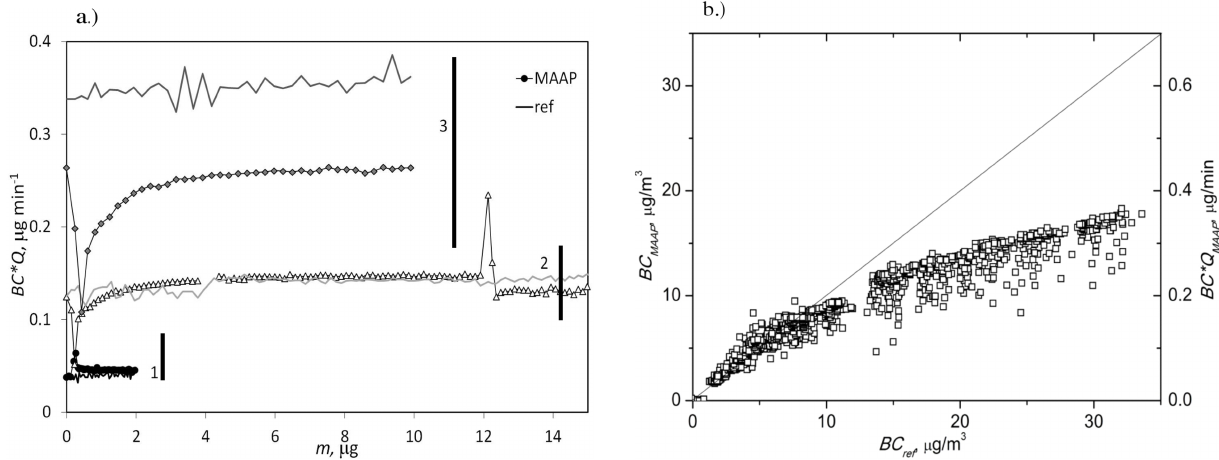
Fig. 3. (a) Examples of the artifact temporal response. Symbol lines indicate data from the high flow rate MAAP, and solid lines data from the reference MAAP. Regimes 1, 2 and 3 correspond to accumulation rates (BC × Q ) of 0.04–0.08µgmin − 1 , 0.08–0.14µgmin − 1 and > 0.14µgmin − 1 , respectively. See text for details. (b) Comparison of the low flow rate reference (BC ref ) and high flow rate (BC MAAP ) BC